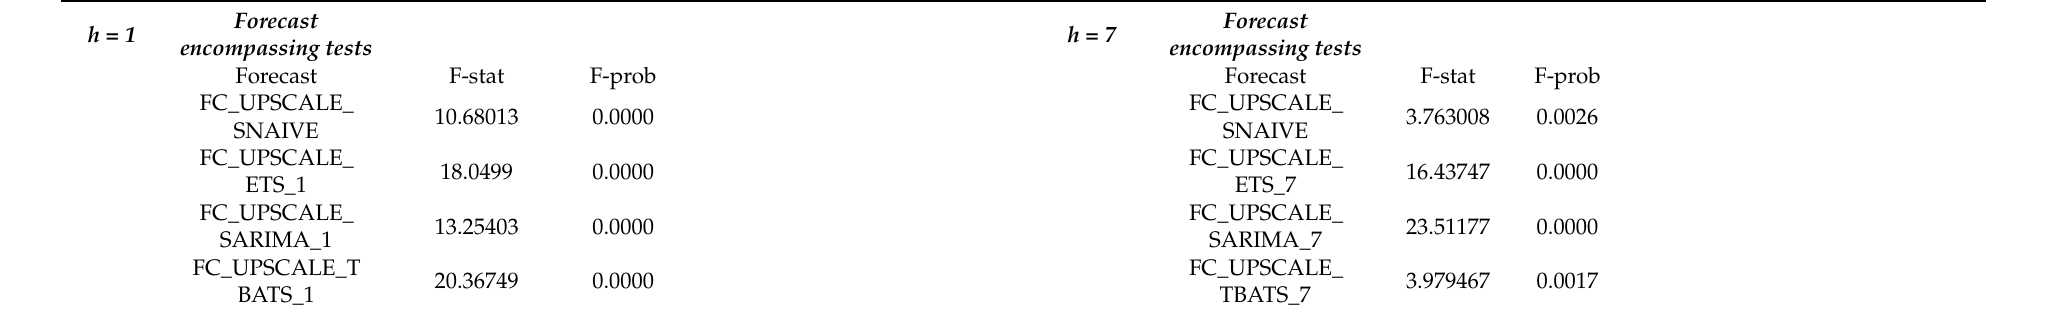
Table A3. Forecast evaluation results for the hotel class ‘upscale’. Source: STR SHARE Center, own calculations using R and